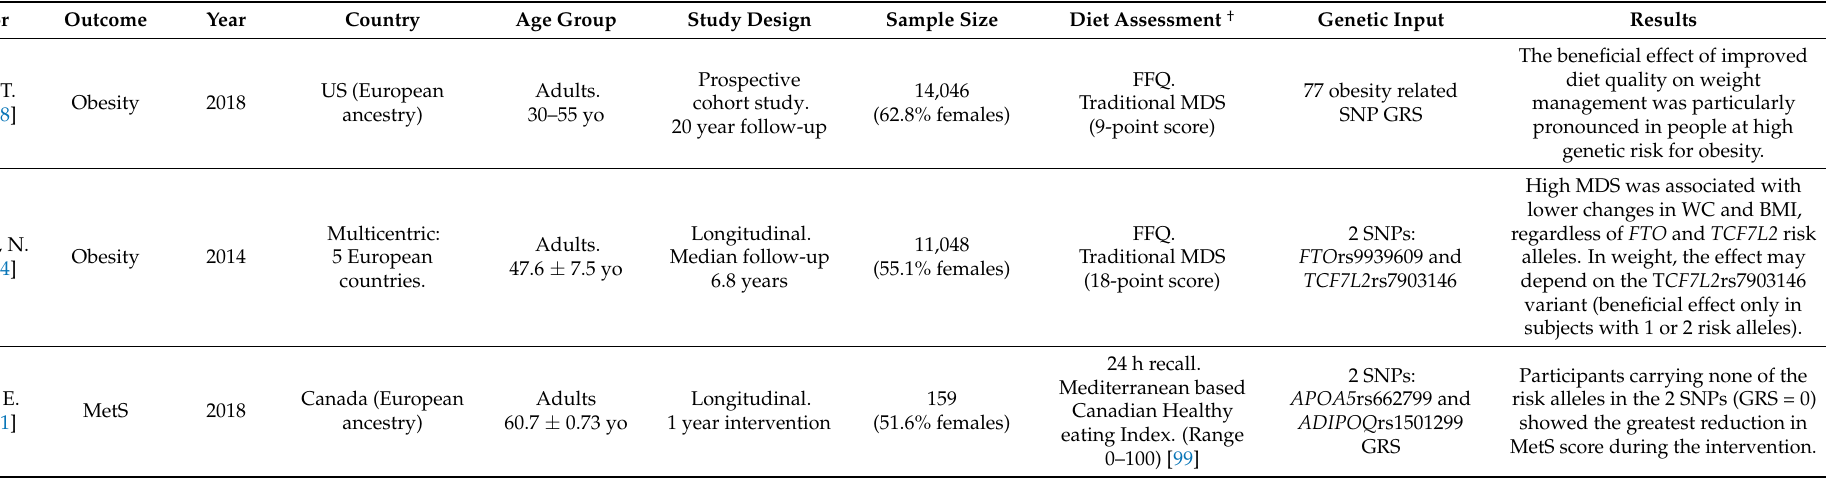
Table 1. Studies considering the individuals genetic profile to modulate the benefits of MD in relation to obesity and MetS in European adults. Articles ordered by outcome (starting with obesity, then MetS) and publication year (starting by most recent).